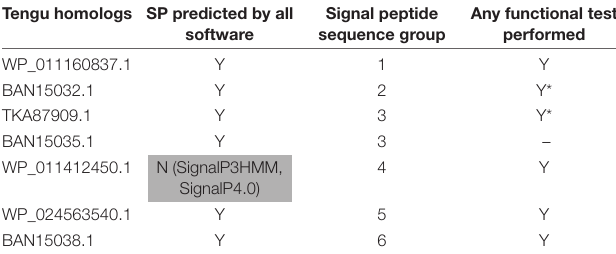
TABLE 1 | Tengu homologs used in this